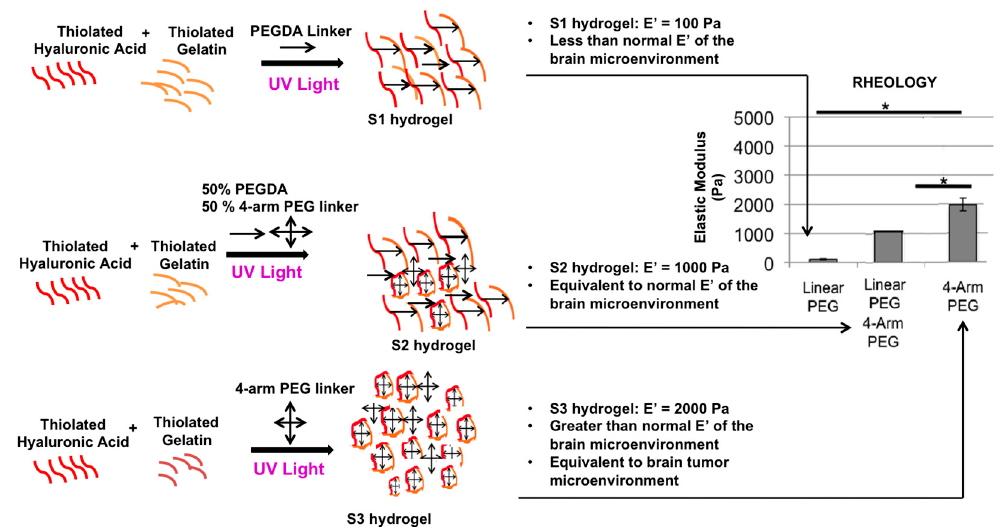
Figure 1. Tuning of hydrogel formulations by cross-linker manipulation. The three elastic moduli (100, 1000 and 2000 Pa) employed in S1, S2, and S3 hydrogels are obtained by modulating ratios of linear versus four-arm PEG-based cross-linkers. The elastic modulus corresponding to an environment less than normal brain elastic modulus (S1), normal brain elastic modulus (S2), and the brain tumor microenvironment (S3). Statistical significance: * p < 0.01 between hydrogel groups.